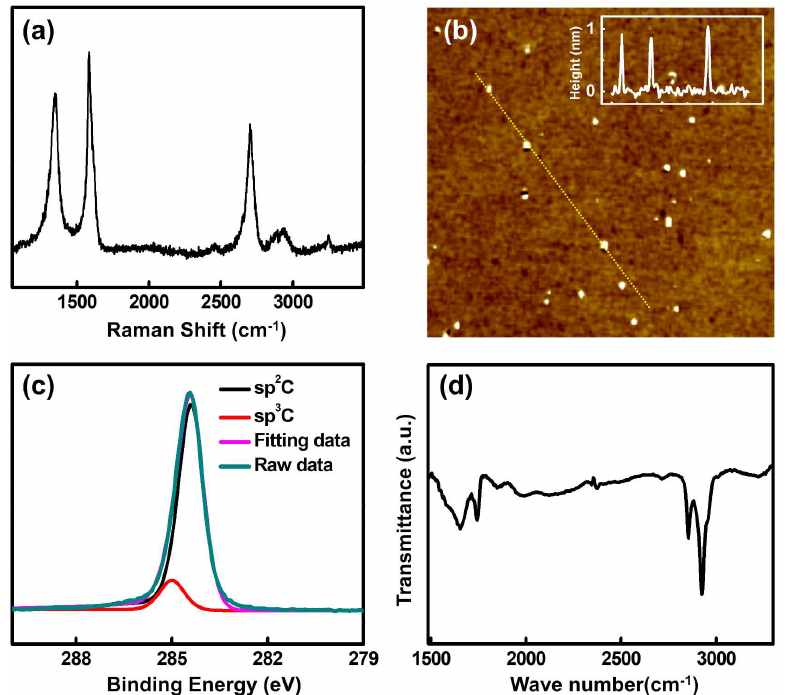
Figure 3. ( a ) The Raman spectra of the detached GQDs. ( b ) The atomic force microscope (AFM) image of the GQDs with the thickness graph of GQDs in yellow (the length of the yellow line inside the AFM image is 2.7 µ m.). ( c ) The X-ray photoelectron spectroscopy (XPS) high-resolution C1s spectrum and ( d ) the Fourier transform infrared (FT-IR) results of the